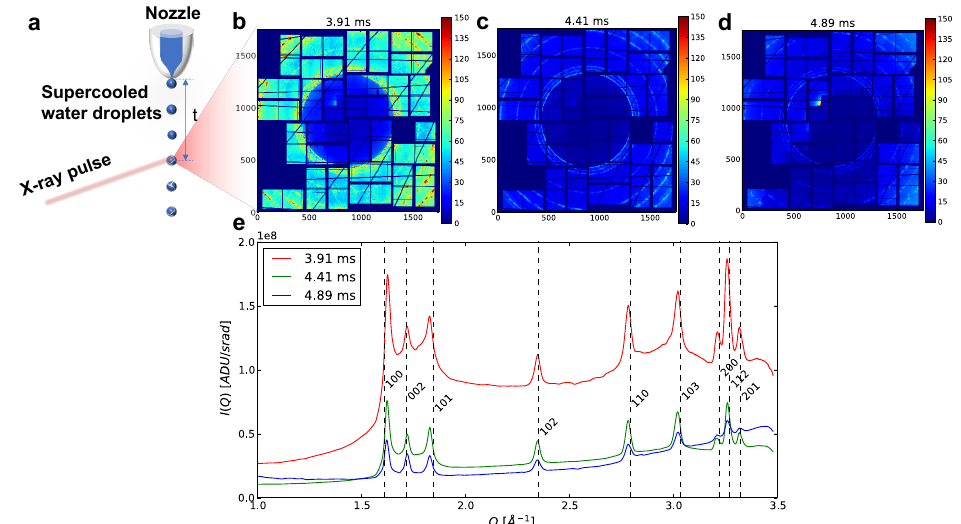
Figure 1. ( a ) Schematic of the experimental setup used to probe ice growth in micron-sized water droplets upon deep supercooling as function of travel time t in vacuo. Virtual powder X-ray diffrac- tion patterns from all ice hits recorded at ( b ) 3.91 ms, ( c ) 4.41 ms, and ( d ) 4.89 ms. ( e ) Mean radial WAXS profiles for all diffraction images containing Bragg peaks. The dashed lines show the expected locations of the Bragg peaks for hexagonal ice I h [51]. The high degree of overlap and the distinctive triple peaks between 1.6–1.85 Å − 1 show that the majority of the ice we observed in this experiment is hexagonal ice I h